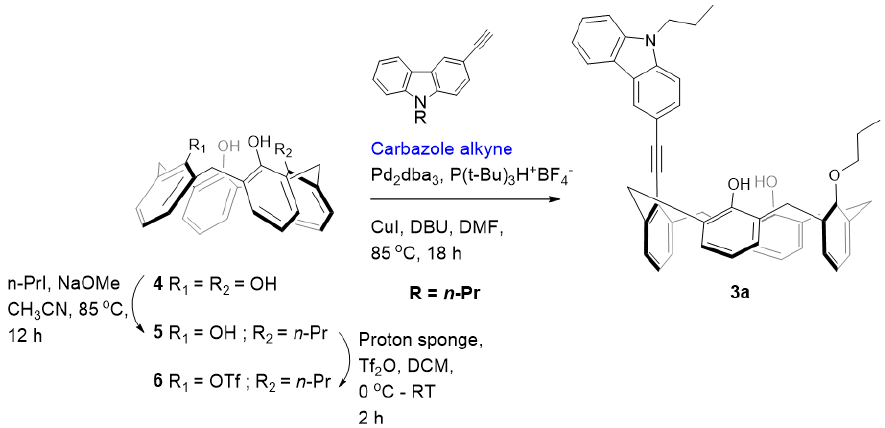
Figure 2. Proposed π interactions between 2 and carbazole-appended calixarenes 3